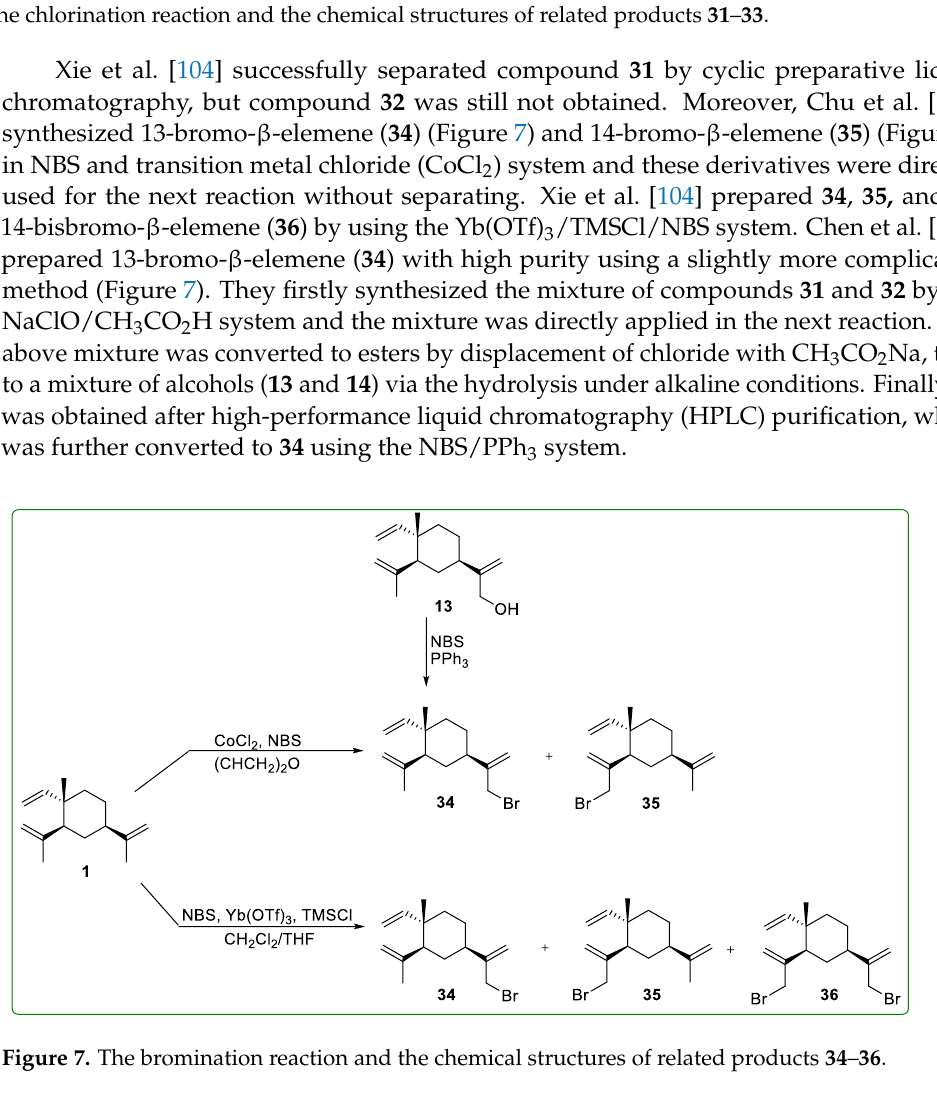
displayed an anti- tumor effect comparable to that of β -elemene on NSCLC cells.